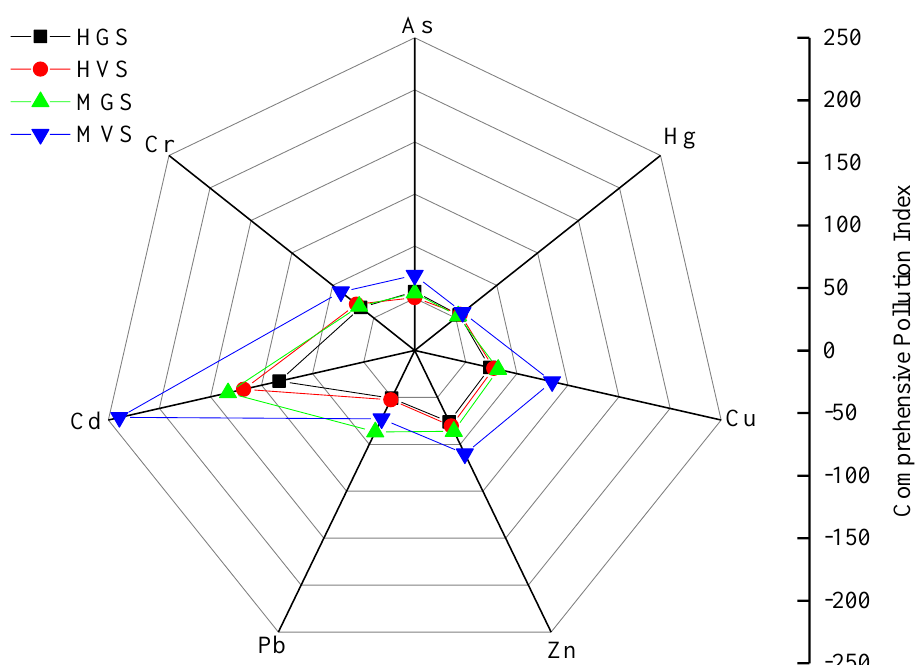
Figure 2. Soil comprehensive pollution index in different pollution types. Note: HGS represents the soil of the grain field in the high geological background area; HVS represents the soil of the vegetable field in the high geological background area; MGS represents the soil of the grain field in the superimposed area of the high geological background and mining activities; MVS represents the vegetable field soil in the area where the high geological background and mining activity overlap. The same as below.